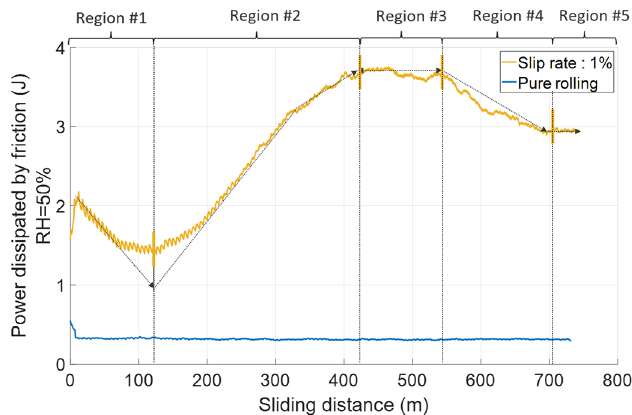
Fig. 18. Power dissipated by friction, slip rate : 1%, RH = 50%, highlight of the regions